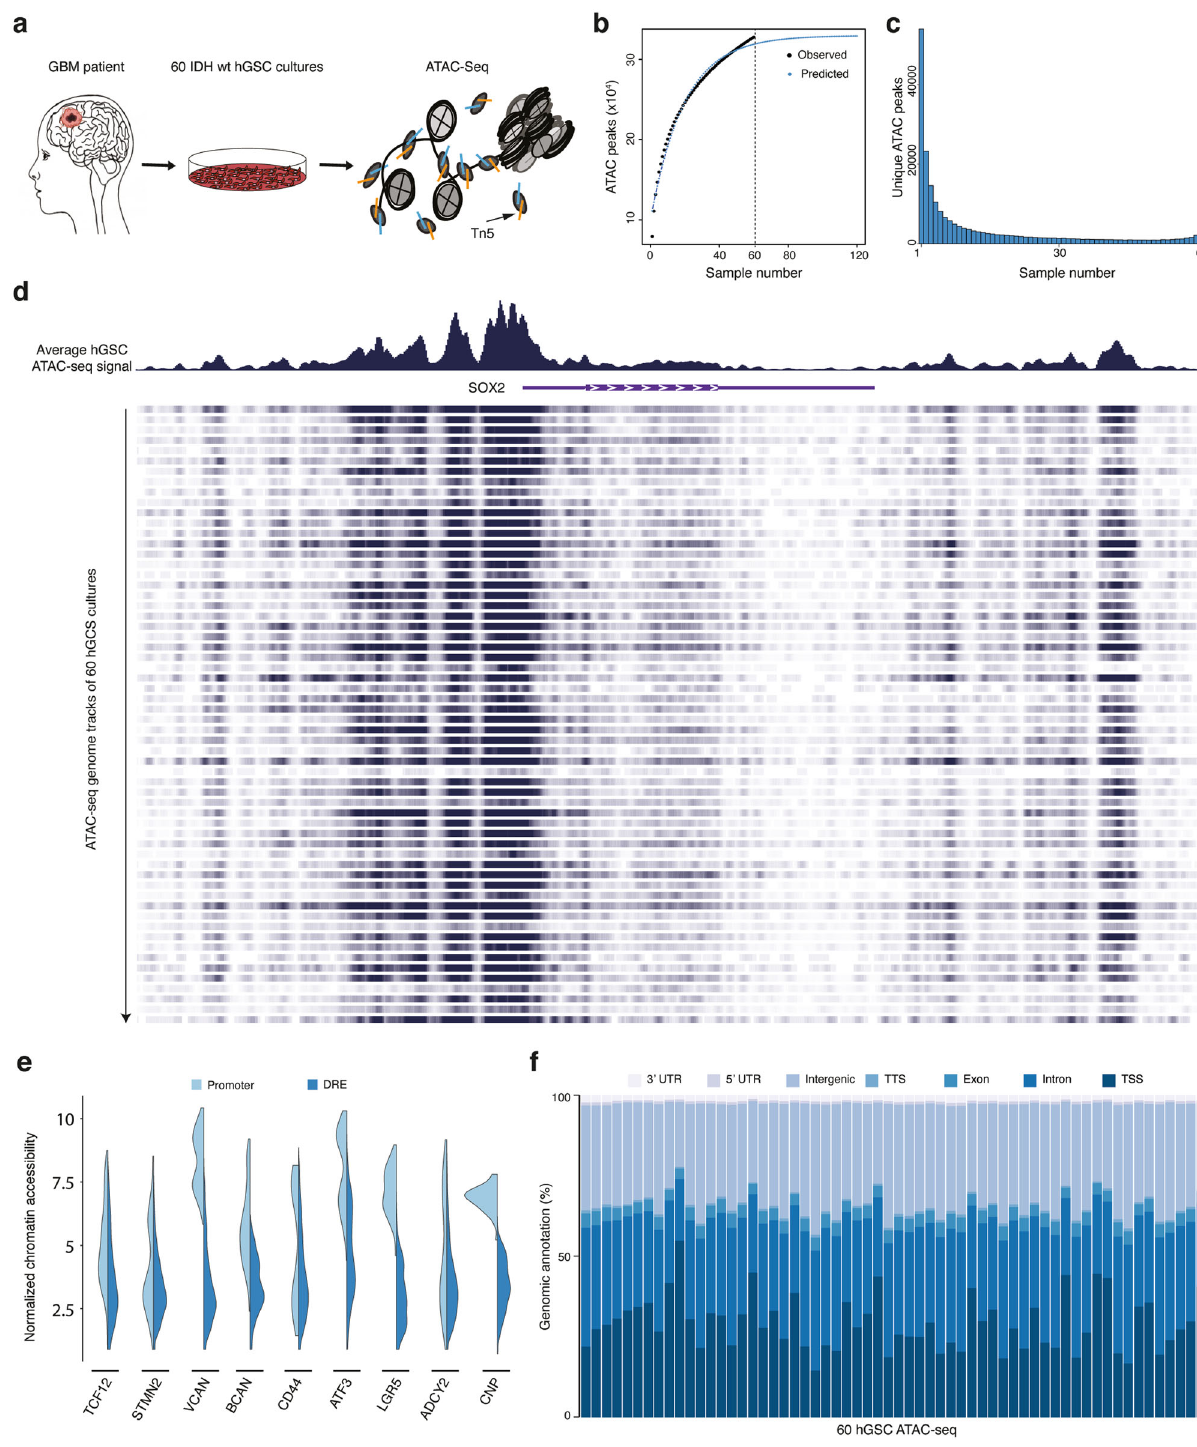
Fig. 2 Heterogeneous chromatin accessibility across 60 patient-derived GSC cultures. a Overview of 60 patient-derived IDH wild-type GSC cultures analyzed by ATAC-seq. Schematic fi gures were produced by the authors. b Saturation analysis using a non-linear model. Number of predicted accessible chromatin regions in GBM (blue dotted line), and number of observed accessible chromatin regions in our 60 hGSC samples (black dotted line). c Histogram of the distribution of unique ATAC peaks in the hGSC cohort. d Genome browser tracks of ATAC-seq signals at SOX2 . Top panel shows the average genome track of all 60 samples. Bottom panel shows individual results. e Violin plots of cohort-wide distribution of chromatin accessibility at promoters and DRE regions of some GBM meta module and cell lineage-relevant genes. f Genomic annotation of ATAC peaks in each hGSC sample. Source data are provided as a Source Data fi le for Fig. 2b, c, e,